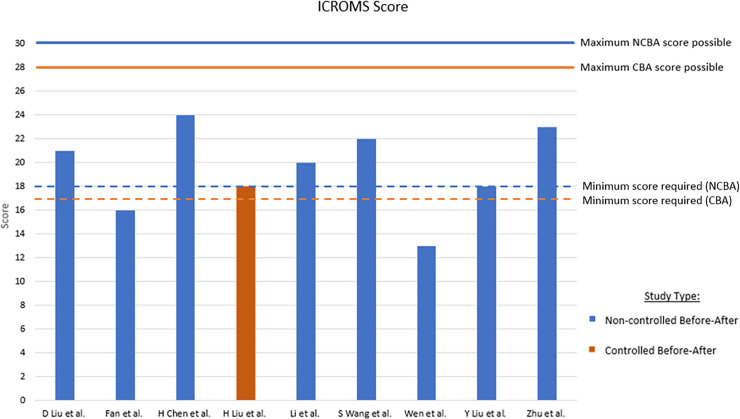
Quality assessment results using ICROMS tool.Minimum required score for NCBA is 18 and CBA is 17. Studies which do not meet this score fail the assessment.